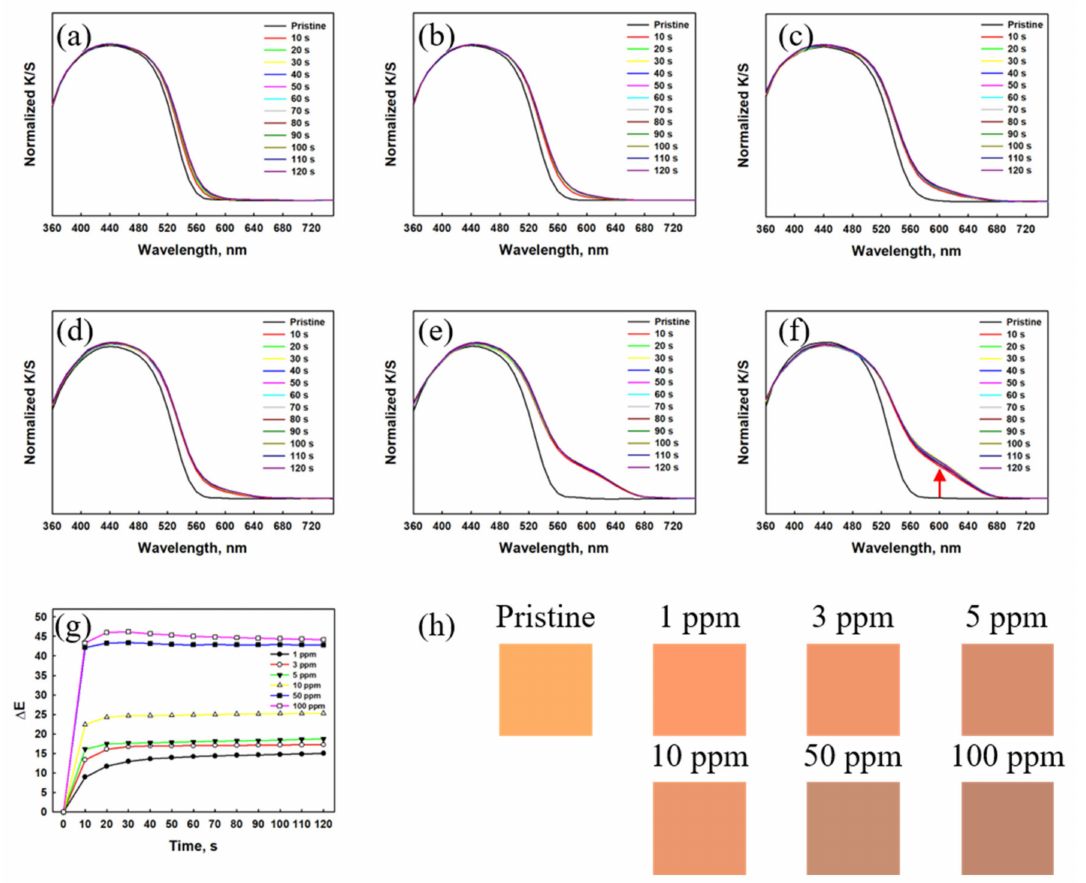
Figure 2. Color data for the textile sensor based on Dye 3 after exposure to various concentrations of gaseous NH 3 : ( a – f ) Time-dependent K / S values upon exposure to 1, 3, 5, 10, 50, and 100 ppm NH 3 ; ( g ) Time-dependent color di ff erences; ( h ) Color